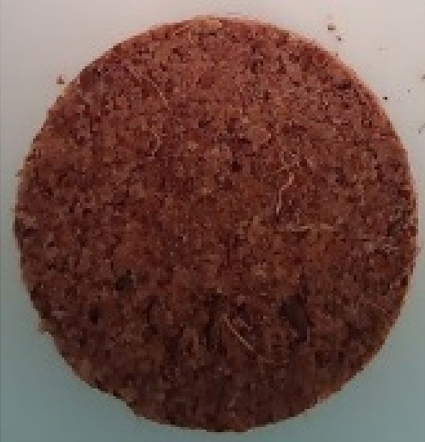
Figure 1. Powdered coir as pills was used as a control